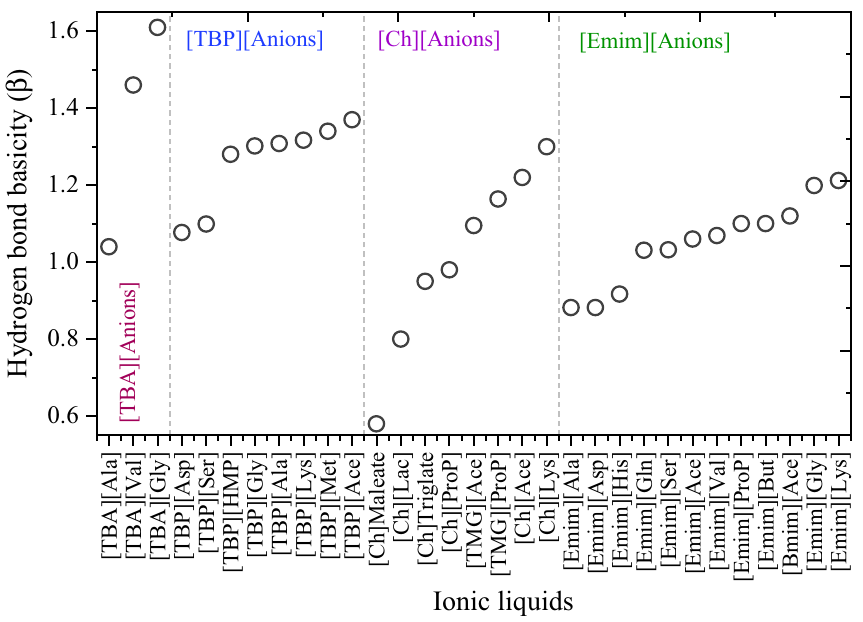
Figure 7. Hydrogen-bond basicity (β) of ionic liquids. The experimental β values are taken from